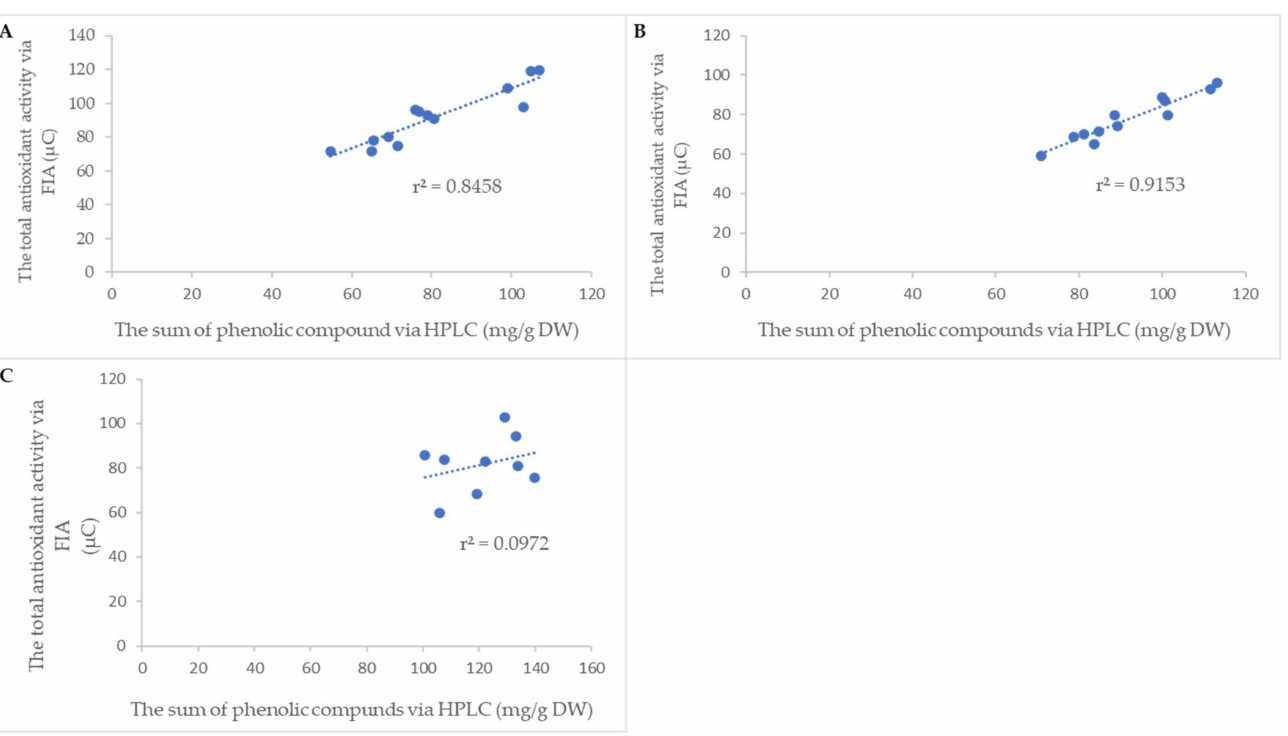
Figure 4. Relationship between the total antioxidant activity via FIA and the sum of phenolic compounds via HPLC in ( A ) leaves, ( B ) bark, and ( C )